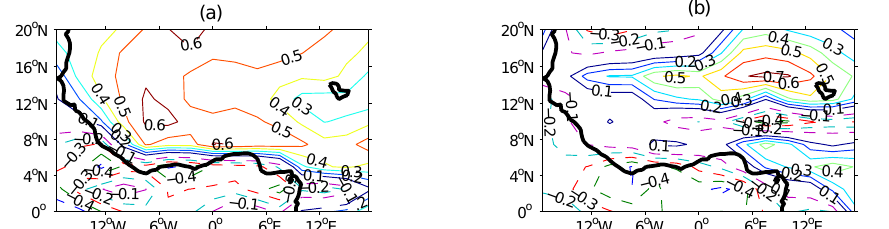
Fig. 7. Linear correlation coefficients between March values of the DSW in- dex used in Fig. 4 and moist static en- ergy fields at 1000hPa in March (a) and August (b) over the period of 1968– 1998. Data source: NCEP/NCAR.